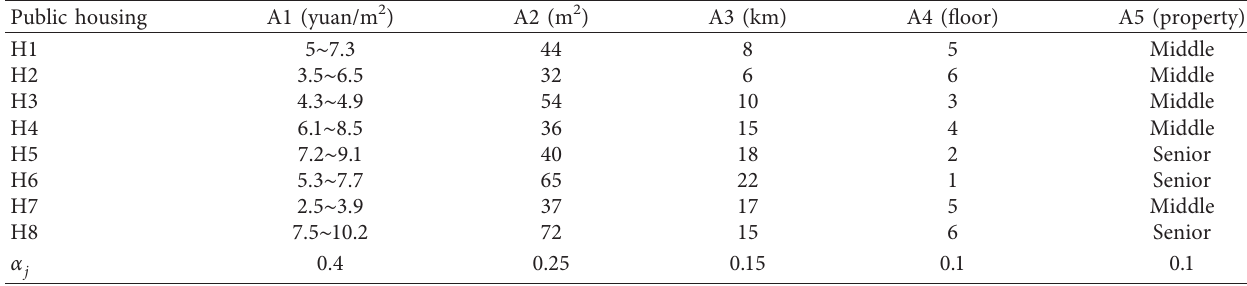
Table 3: The actual output information of attributes characteristics of the 8 public housings.